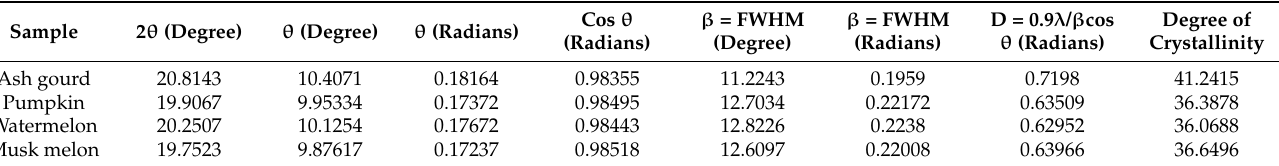
Figure 6. Diffractogram of seeds. Table 8. Details of 2 θ peaks and degree of crystallinity obtained from XRD diffraction of cucurbit seeds.